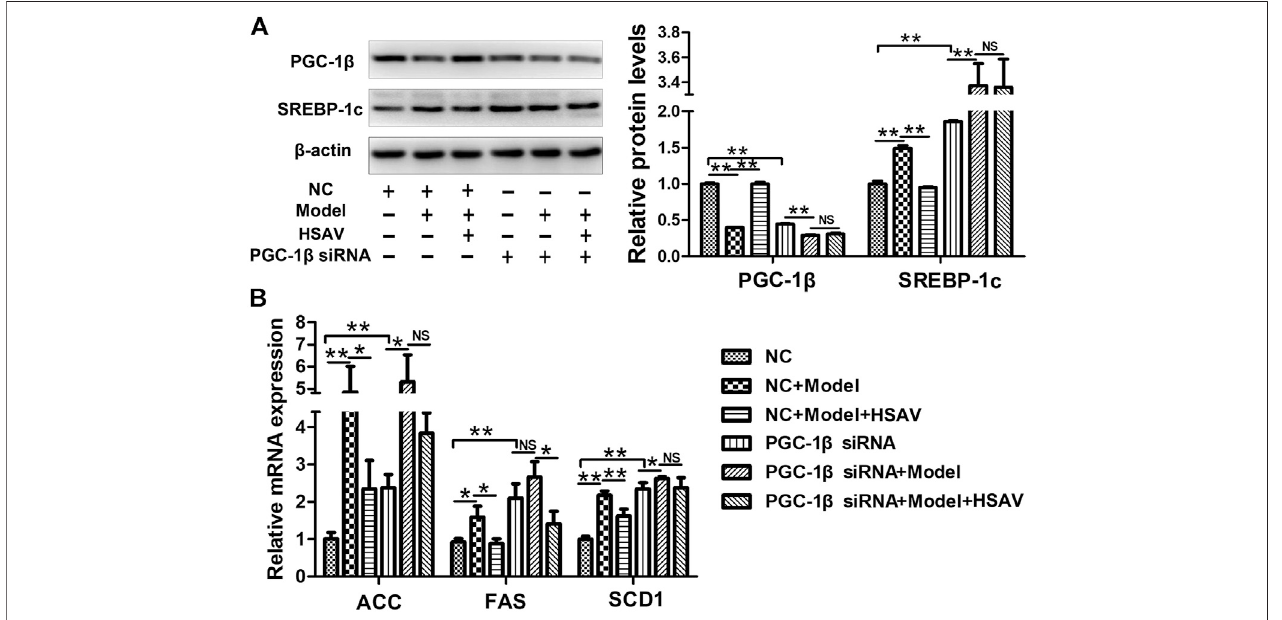
FIGURE 9 | Effects of HSAV on PGC-1 β pathway in HepG2 cells transfected with PGC-1 β siRNA. (A) The expression levels of PGC-1 β and SREBP-1c; (B) the mRNA levels of ACC, FAS and SCD1. Data are presented as the mean ± SD (n (cid:2) 3). * p < 0.05, ** p < 0.01, NS, no signi fi cance.